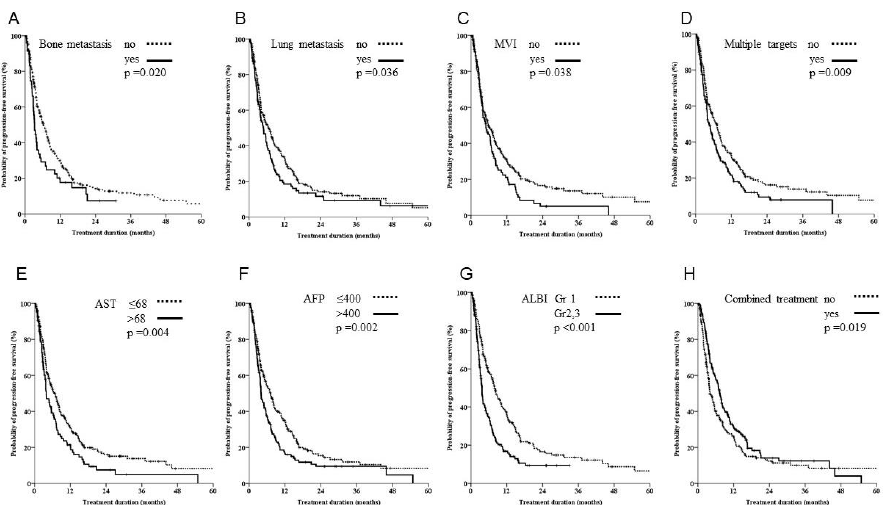
Figure 2. Kaplan-Meier estimates of survival rates stratified by different organ metastasis, vascular involvement, hepatitis or combined treatment. ( A – D ) Patients with bone metastasis, lung metastasis, macroscopic venous invasion (MVI) or multiple lesions had significantly poorer outcomes in terms of progression-free survival. ( E , F ) Patients with aspartate transaminase (AST) levels twice those of normal values and alpha fetoprotein (AFP) levels of >400 ng/mL had significantly poorer outcomes in terms of progression-free survival. ( G ) Patients with grade III albumin-bilirubin had poor outcomes compared with patients with grade I/II. ( H ) A combination of sorafenib and ablation treatment yielded significantly better outcomes.